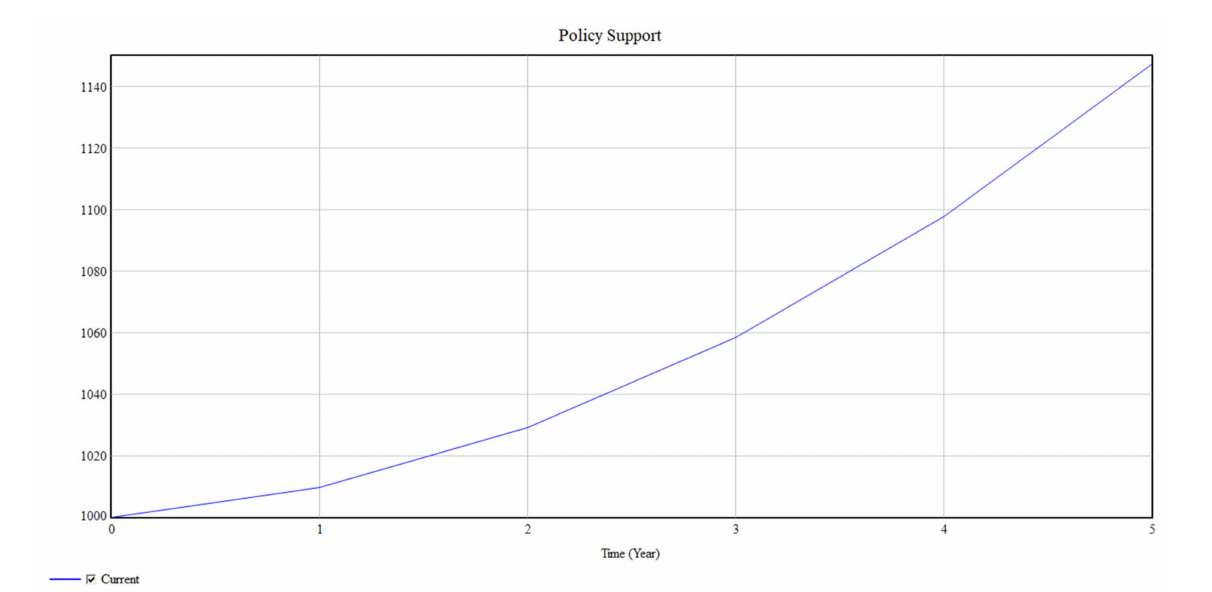
Figure 12. Simulation graph for Policy